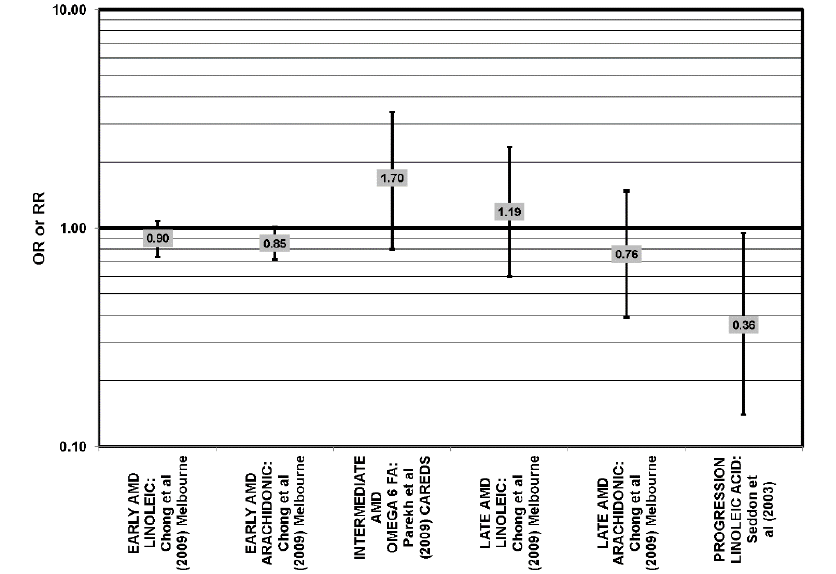
Figure 12. Odds or risk ratio for intermediate AMD, neovascular AMD (NEO) or AMD progression; high vs. low intake of omega-6 fatty acids: prospective